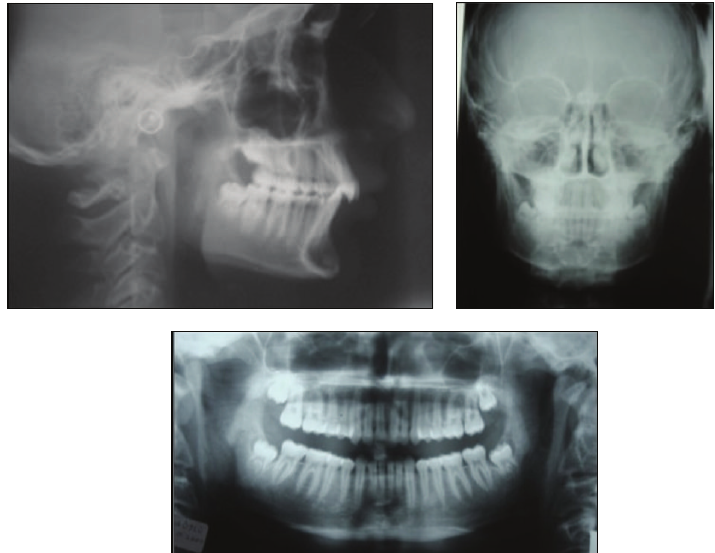
Figure 2: Pretreatment lateral, frontal, and panoramic radiographs.